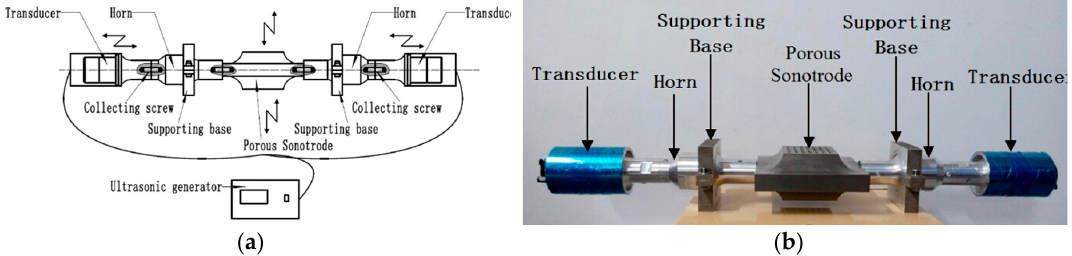
Figure 1. Schematic diagram ( a ) and picture ( b ) of ultrasonic system with porous sonotrode [14].